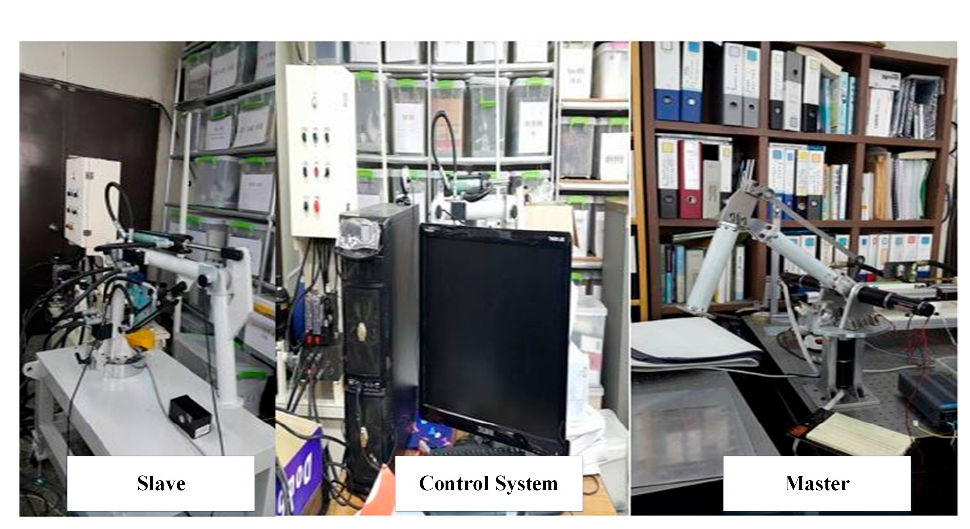
Figure 8. Experimental setup.